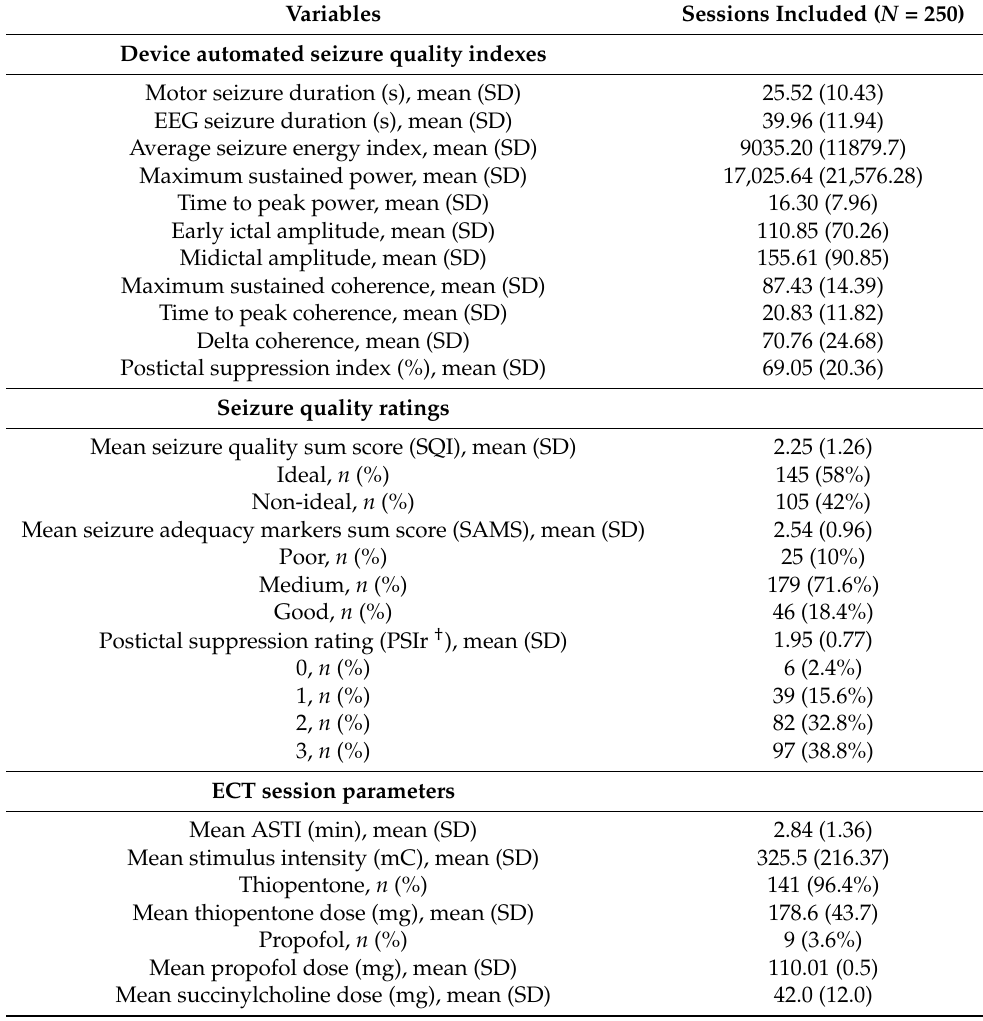
Table 2. ECT session seizure